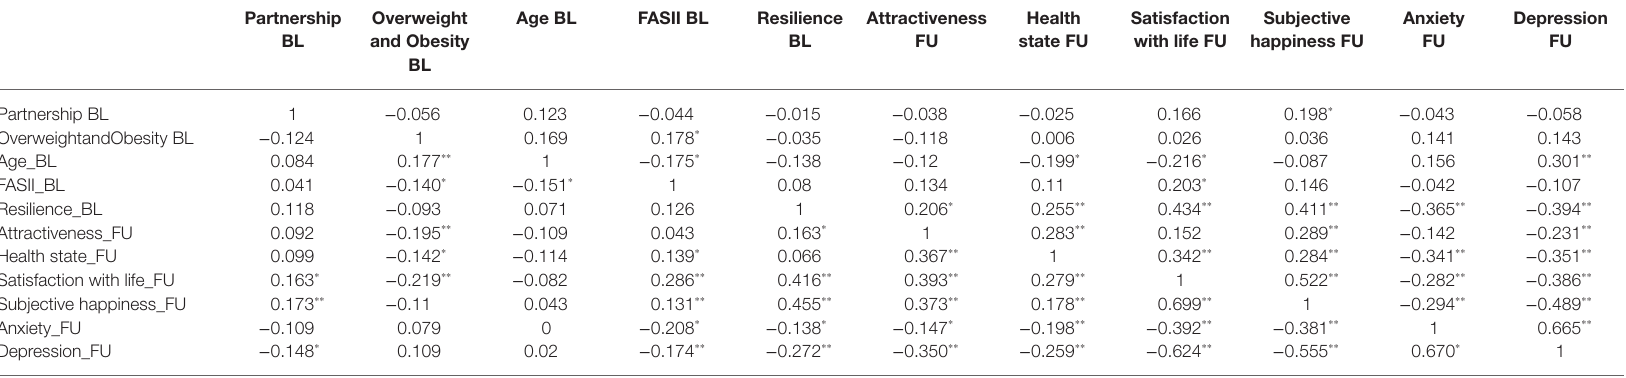
TABLE 2A | Bivariate correlations among the psychological predictors within Germany, with female below diagonal and male above diagonal.